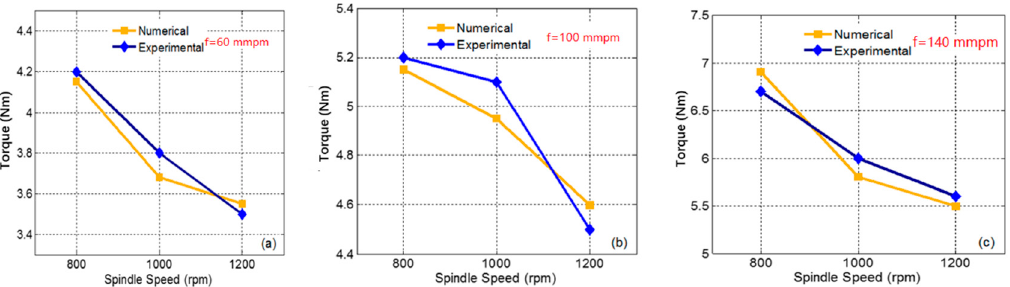
Figure 8. Data comparison for different feed speeds: ( a ) feed speed is 60 mm/min; ( b ) feed speed is 100 mm/min; and ( c ) feed speed is 140 mm/min.